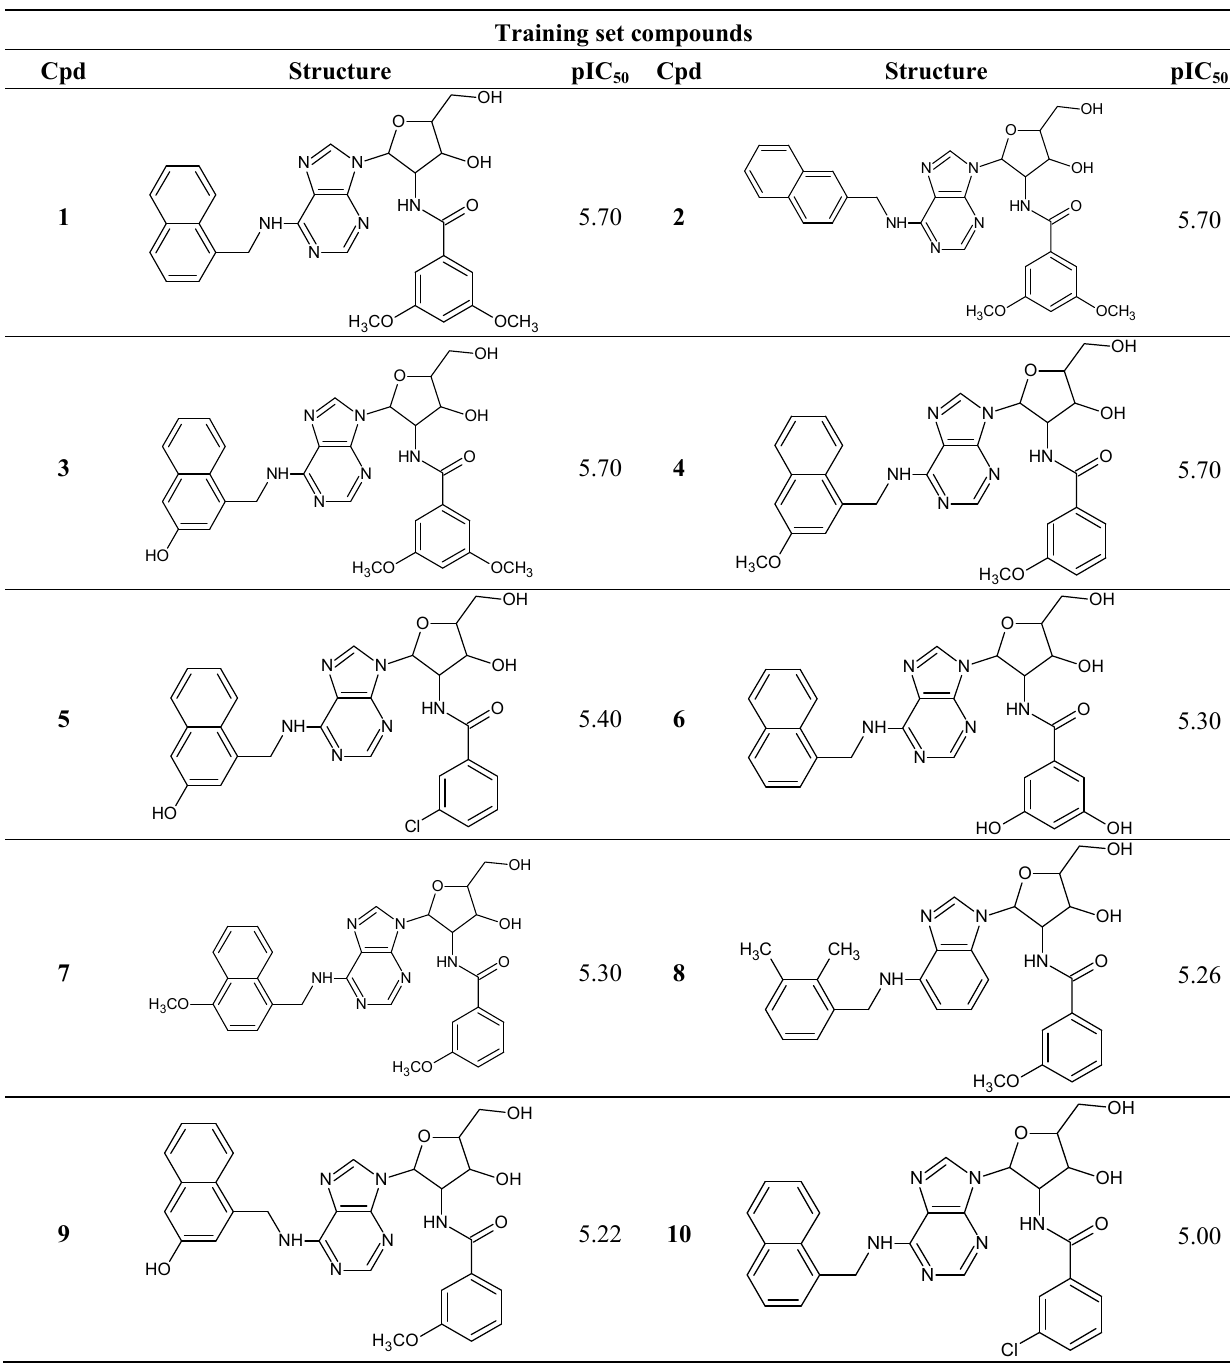
values for training and test set 50